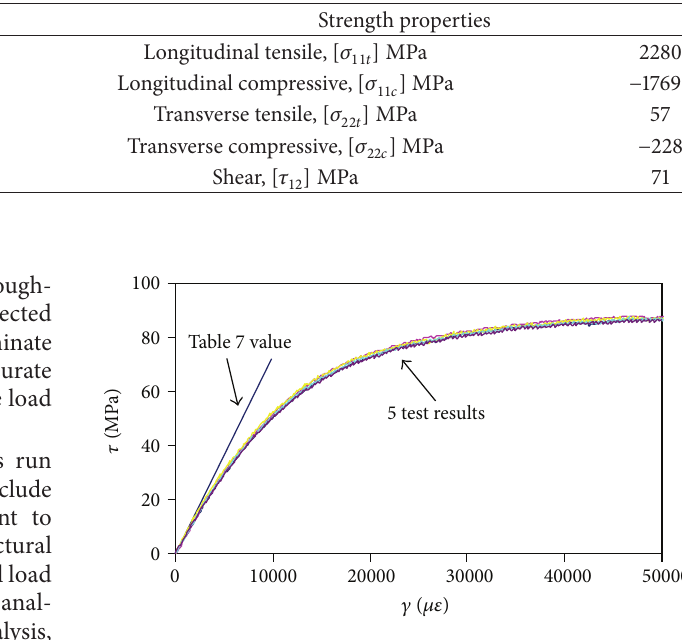
Figure 10: Shear stress-strain curve of AS4/3501-6 ( ± 45 ∘ tension test)